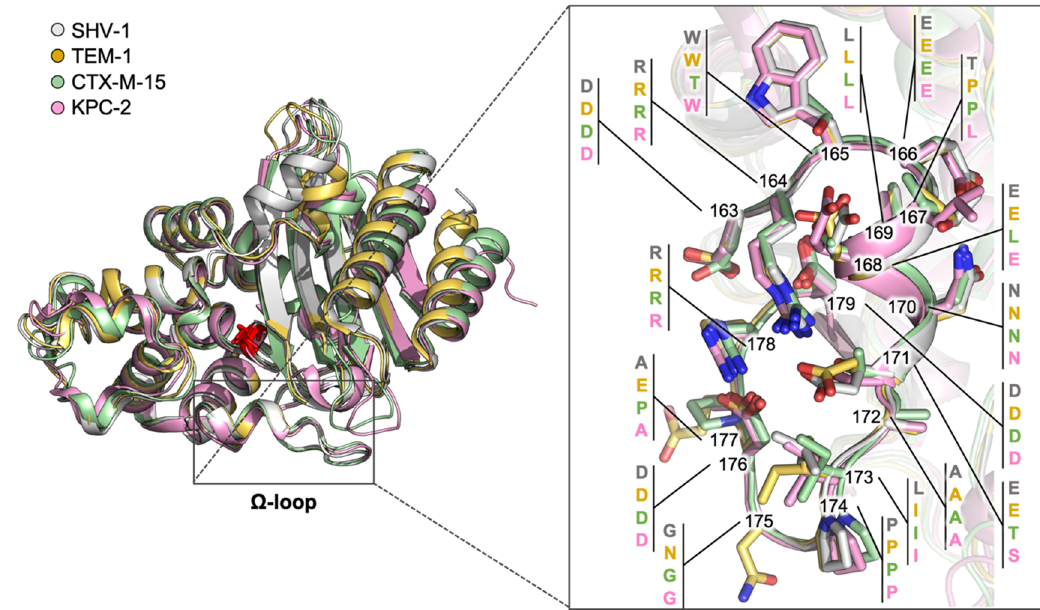
Figure 1. Alignment of class A BLs in cartoon representation: SHV-1 (gray), TEM-1 (dark yellow), CTX-M-15 (green), KPC-2 (pink) (PDB IDs: 4zam, 1ero, 4hbt, 3rxw, respectively). A close-up on the Ω -loop is reported in the right panel: residues are labeled and shown as capped sticks. Each residue number has been linked to four residue names, one for each aligned BL, with a consistent color code. Residues are numbered according to the standard numbering scheme [28].